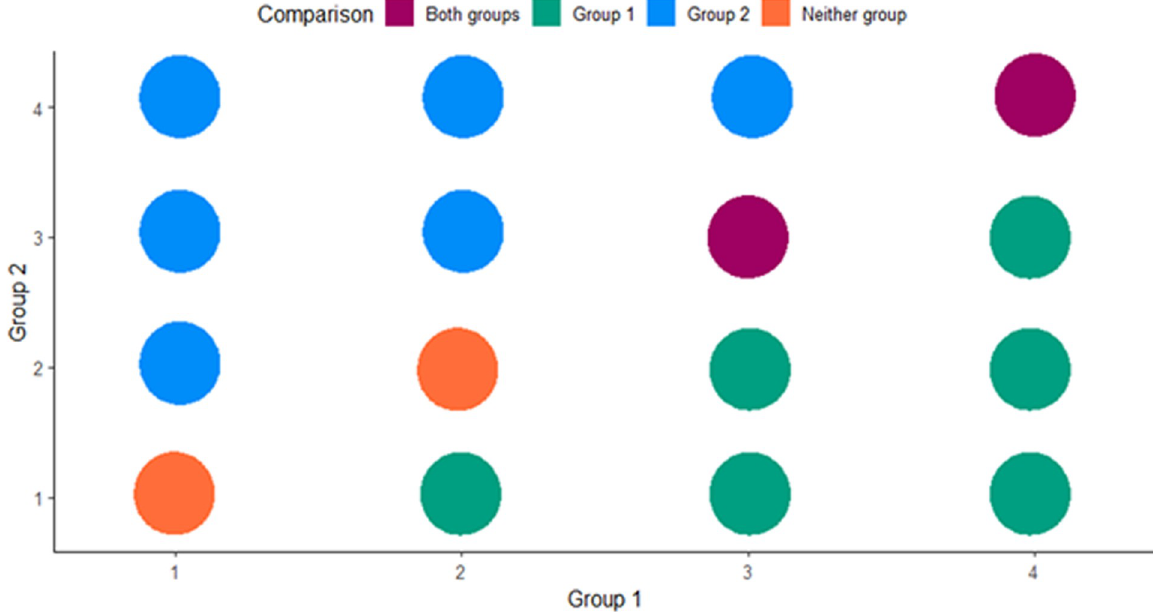
Fig 1. Idealized multi-pie chart graph representing expected alignment between individual evaluation and group comparison items on the Eco-BLIC and PLIC. The x- and y-axes represent rankings on the individual evaluation questions for Groups 1 and 2 (or field and lab groups), respectively. The colors in the legend at the top of the figure denote responses to the group comparison items. In this idealized example, all pie charts are the same size to indicate that the student answers are equally proportioned across all answer combinations.